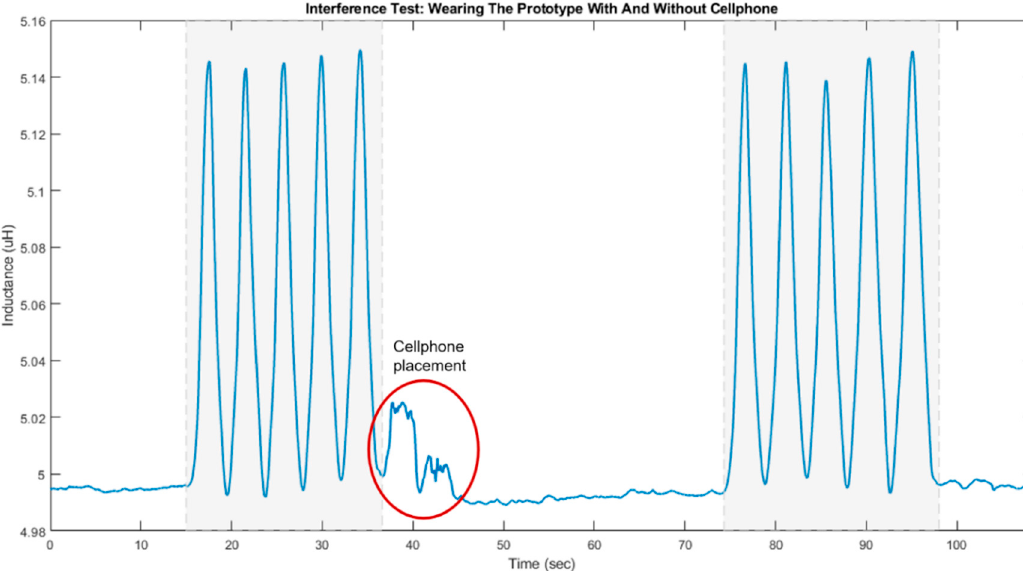
Figure 9. Inductance values ( µ H) recorded from the interference test, where a single participant was wearing the prototype and performed forward bending. In the second set of forward bend, the participant had the cellphone inside the jeans’ back pocket. In each case, the periods of forward bending are highlighted in grey shade. The red circle shows when the cellphone was put inside the back pocket.